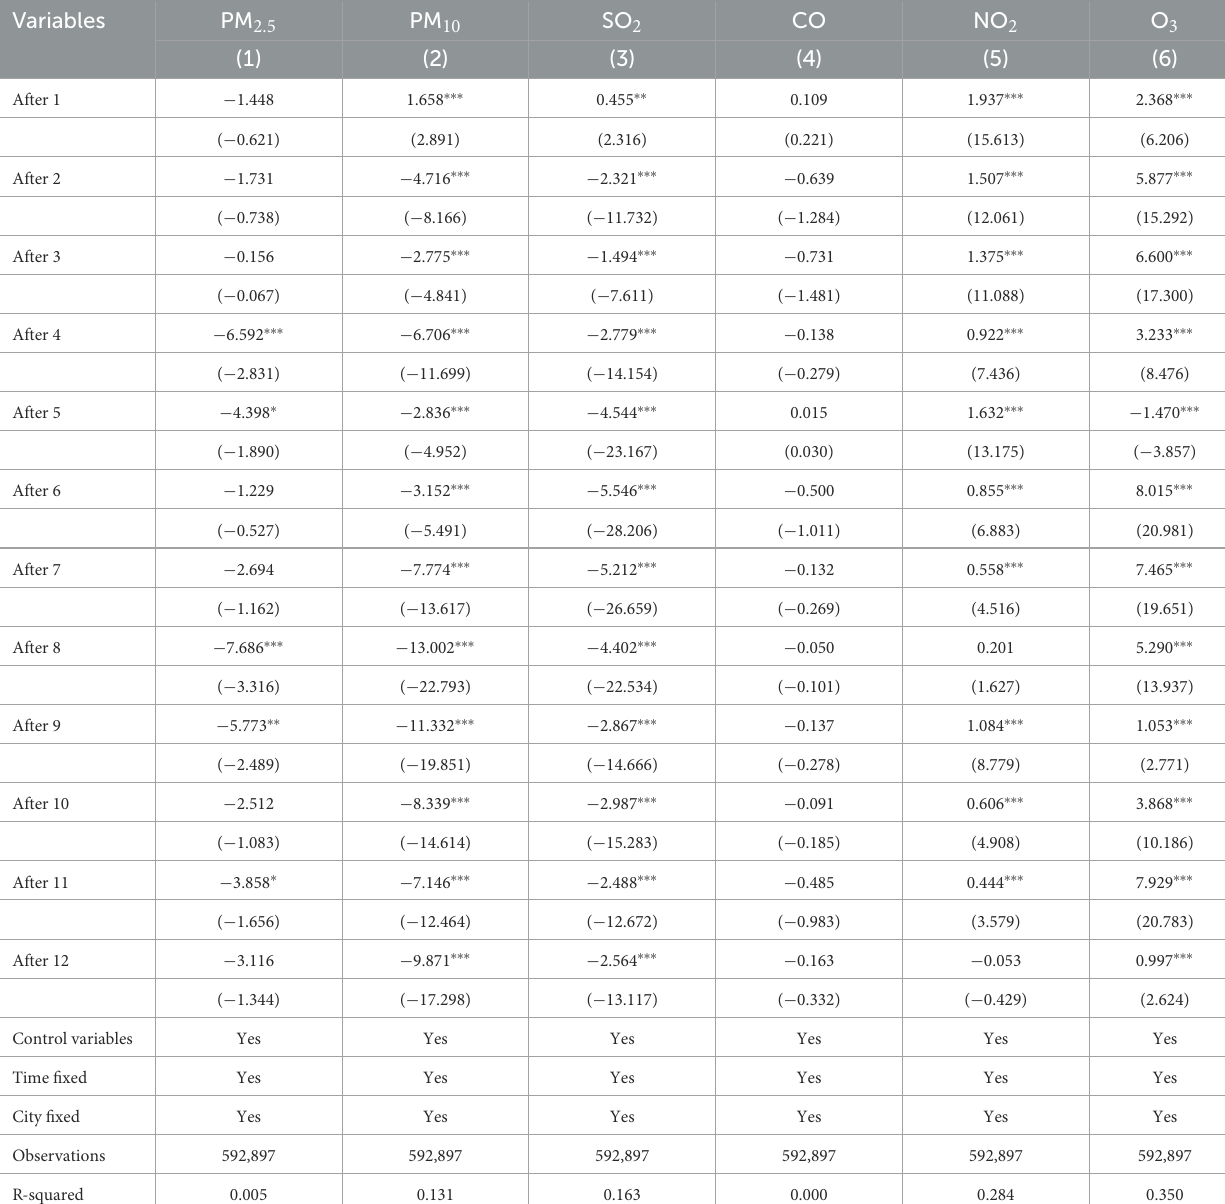
TABLE 7 Dynamic effect for different air